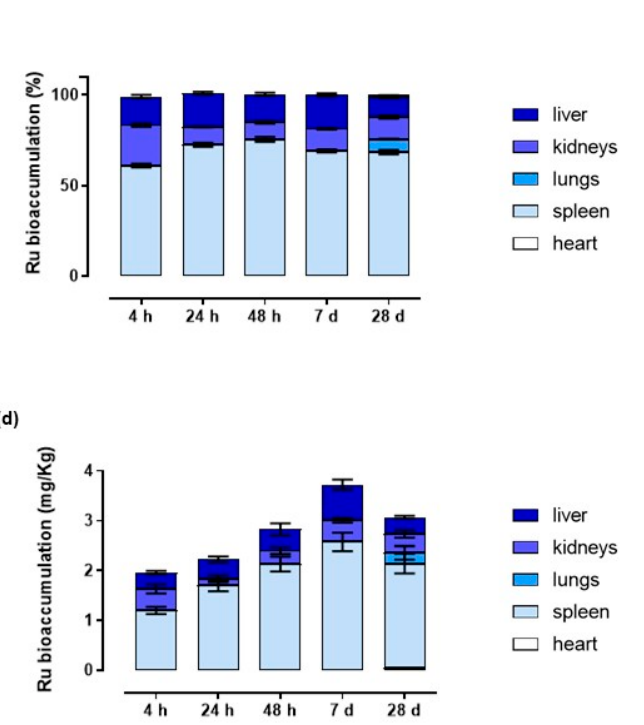
Figure 4. ( a , b ) Percentage of ruthenium amounts plotted in pie charts uncovered in the indicated body districts, including tumour lesions, at the endpoint of the preclinical study. After weekly administrations of HoThyRu ( a ) (4.5 mg/kg, i.p. , once a week for 4 weeks) and HoThyRu/DOTAP ( b ) (15 mg/kg, i.p. , once a week for 4 weeks), the mice were sacrificed, and organs and tissues appropriately collected to analyse the ruthenium content by ICP-MS ( n = 5 for the HoThyRu-treated group and n = 10 for the HoThyRu/DOTAP-treated group). ( c , d ) Ruthenium bioaccumulation in mice over time (4, 24, 48 h, and 7 days, as reported in bar graphs) after a single administration of HoThyRu/DOTAP (15 mg/kg, i.p. ), or after weekly administrations (28 d) of HoThyRu/DOTAP (15 mg/kg, i.p. , once a week for 4 weeks) estimated both as ( c ) percentage and ( d ) absolute metal quantity expressed as mg/kg of body weight ( n = 5 animals per time point). Statistical analysis was conducted by one-way ANOVA followed by Bonferroni’s for multiple comparisons.